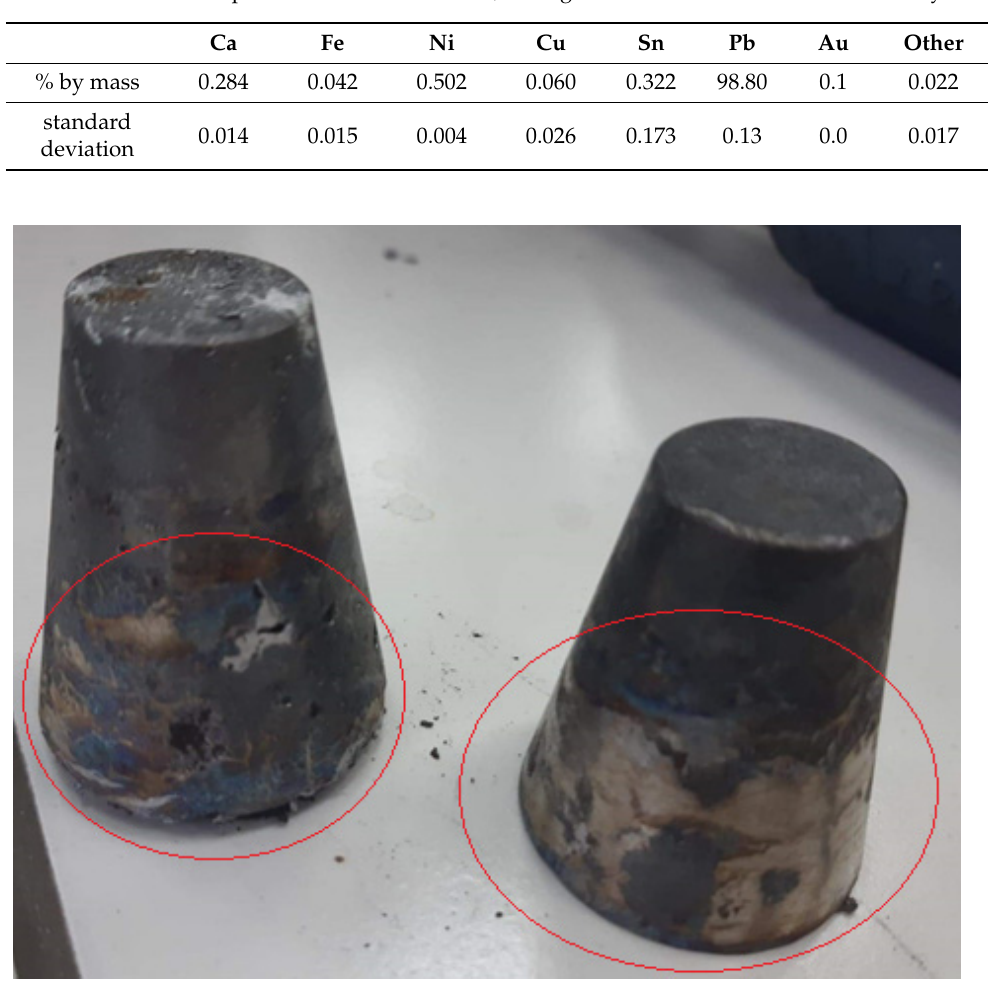
Table 3. Chemical compositions of the crude lead, averages and standard deviation of 10 analyses.